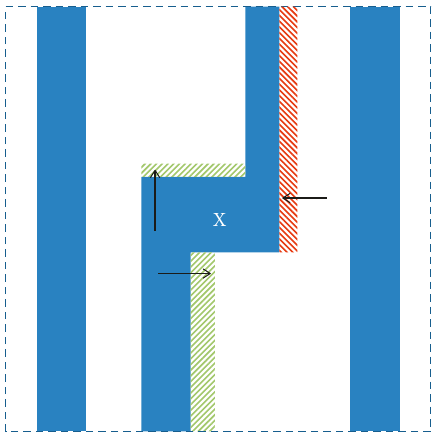
Figure 5: Two clips overlapped with each other [1].